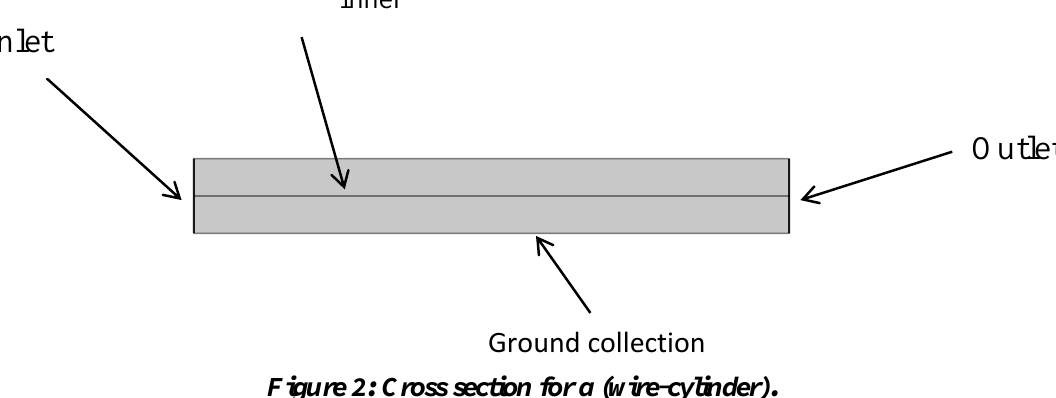
Figure 2: Cross section for a (wire-cylinder).